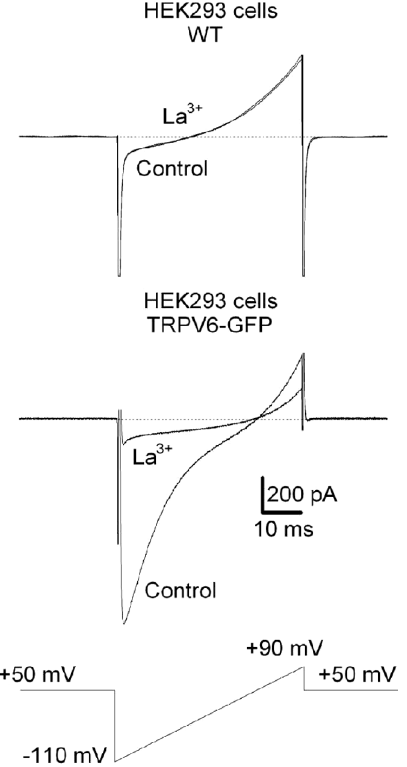
Figure 2. Comparison of electric currents from wild type HEK- 293 cells and TRPV6/EGFP HEK-293 cells. The measured currents in wild type HEK-293 cells are inductive of no over-expression of TRPV6 channels. For TRPV6/EGFP HEK-293, the absence of La 3 + ions showed a large current with the current being efficiently blocked in the presence of La 3 + ions. Effect of La 3 + ions (10 m M) on currents evoked by a 50 ms ramp (bottom) in wild type HEK-293 cells and TRPV6/EGFP HEK-293 cells.